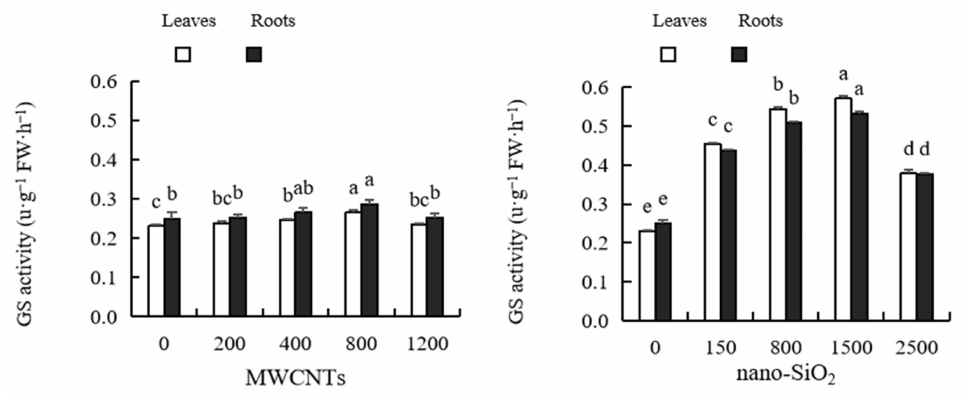
Figure 8. Effect of different concentrations of MWCNTs and nano-SiO 2 on GS activity in maize. Note: Data are expressed as mean ± standard deviation. Different letters within the same column indicate significant difference at 5% level.